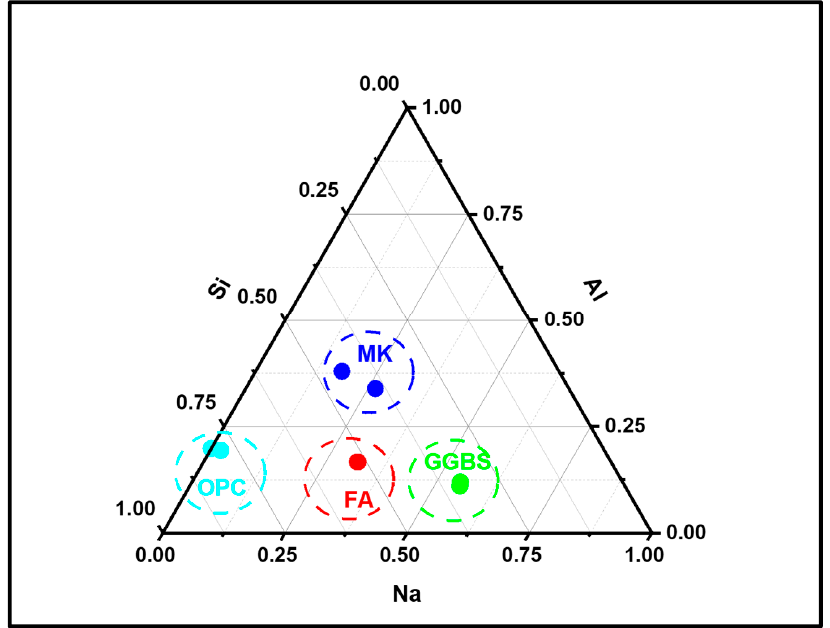
Figure 14. Ternary plot of Na vs. Al vs. Si.